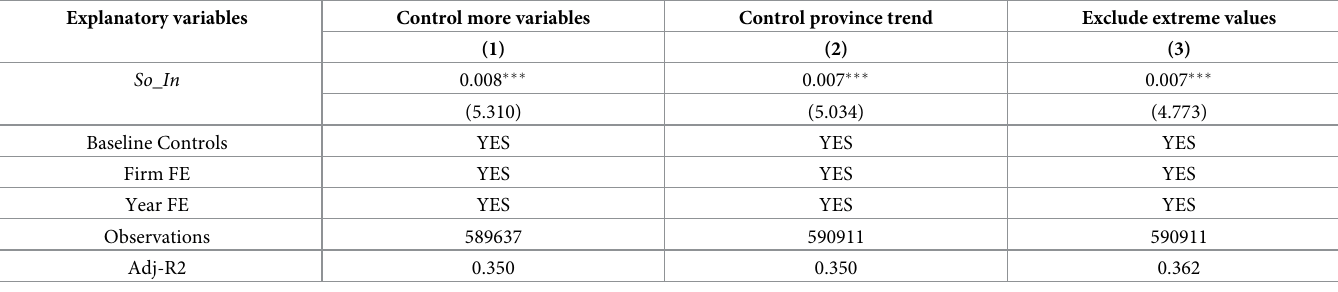
Table 6. Robustness Test